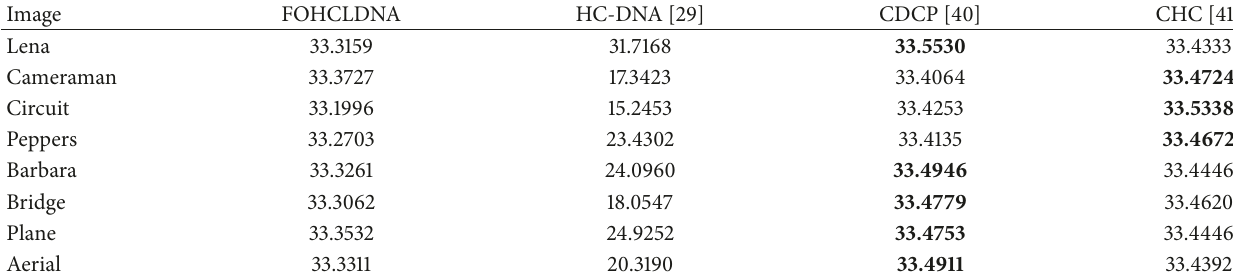
Table 9: The average UACI (%) of running the schemes 10